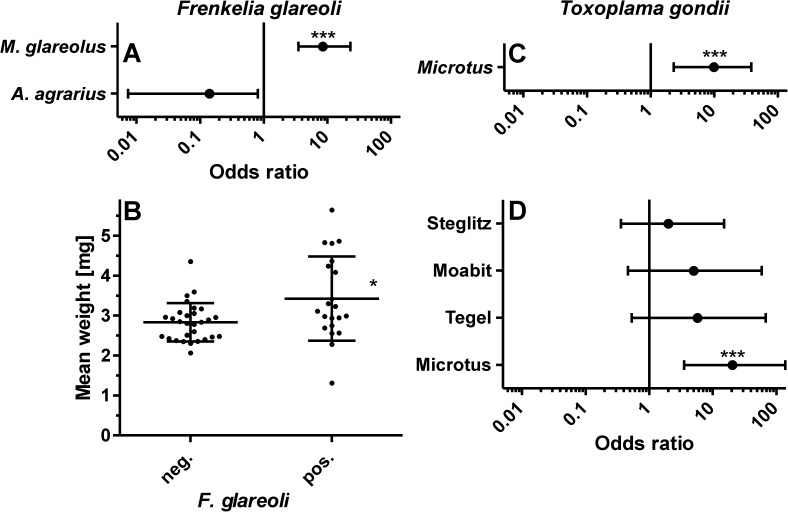
Statistical analysis of parameters affecting the probability to detect DNA from Coccidia.(A) Odds ratios with 95% confidence intervals are shown for variables determining the risk for detection of Frenkelia glareoli in Myodes glareolus and Apodemus agrarius compared to Apodemus flavicollis. A model considering only the rodent species as explanatory variables is presented. Odds ratios for Apodemus sylvaticus, Microtus agrestis and Microtus arvalis were 9.3×10−8 and were omitted from the figure due to the fact that the parasite was not found in any of these animals and the resulting very wide confidence intervals. (B) Distribution of dry eye lens weights, as an indirect indicator for age, in M. glareolus with and without F. glareoli infection. Only animals trapped in 2011 were considered since eye lens weights were not determined in 2010. Individual points representing means of two eye lenses are shown together with means ± SD for all animals in the group. *, p < 0.05 in a Mann-Whitney U test. (C, D). Odds ratios with 95% confidence intervals for the probability to detect Toxoplasma gondii DNA in the brain by PCR are illustrated. The model in (C) considered only the rodent genus, the model in (D) genus and study location. Myodes is not shown since T. gondii was not found in these rodents. The odds ratios for Myodes spp. was 7.0×10−8 and the 95% confidence interval was very wide. Reference categories were Apodemus for genus and Gatow for study location. All odds ratios and significance levels were calculated by logistic regression followed by t test to determine the significance of the effects. ***, p < 0.001.